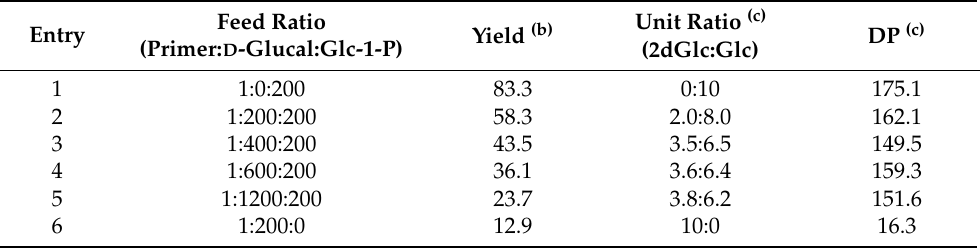
Table 1. Thermostable GP-catalyzed (co)polymerization of Glc-1-P, D -glucal/Glc-1-P, or D -glucal from maltooligosaccharide-modified PGA (a)